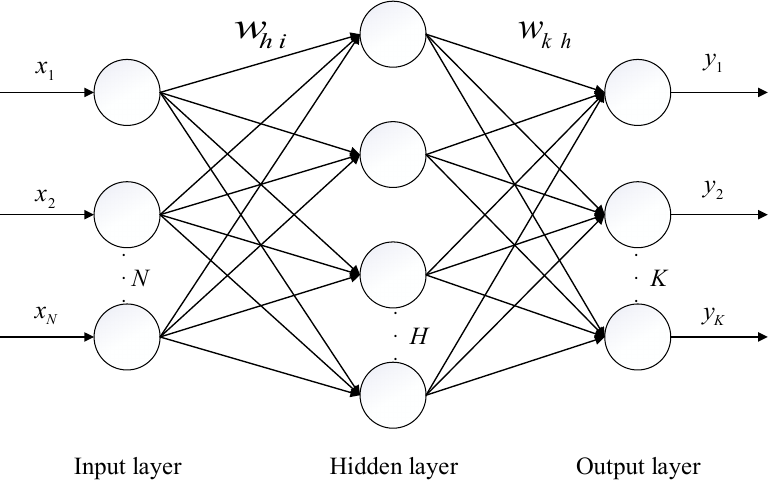
Figure 5. Structure of BP neural network model.